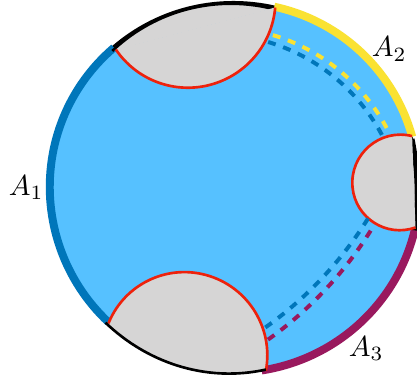
Figure 21 . In this case area((cid:6)( A 1 )) = area((cid:6)( A 2 )) + area((cid:6)( A 3 )) and the (cid:13)ux on O will be zero. Lower